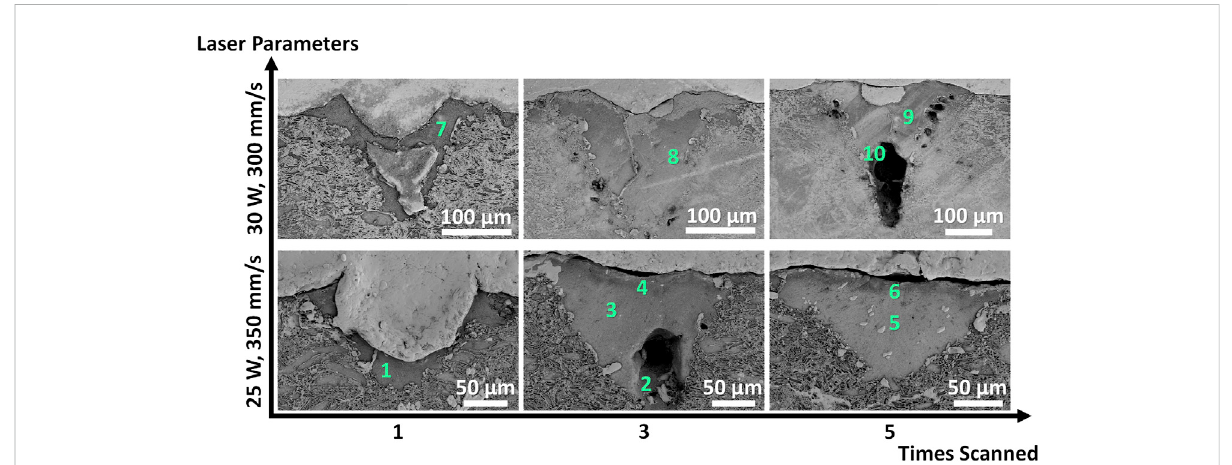
FIGURE 11 Scanning electron microscopy images of the melt pools scanned at each corresponding laser parameter set. Points marked on each fi gure represent where energy dispersive spectroscopy analyses were performed and correspond to the rows of numerical EDS data in Table